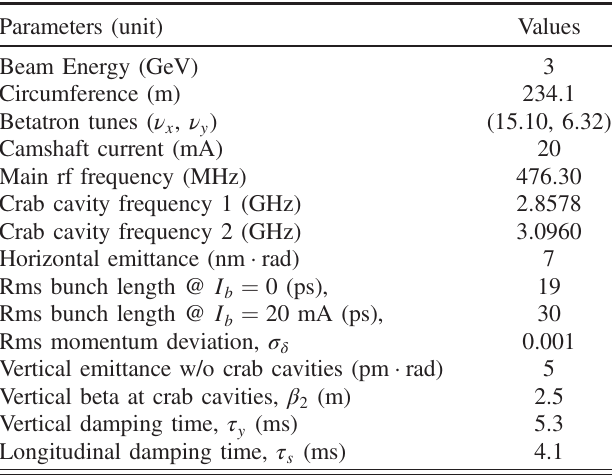
TABLE I. The 2FCC lattice parameters for SPEAR3.